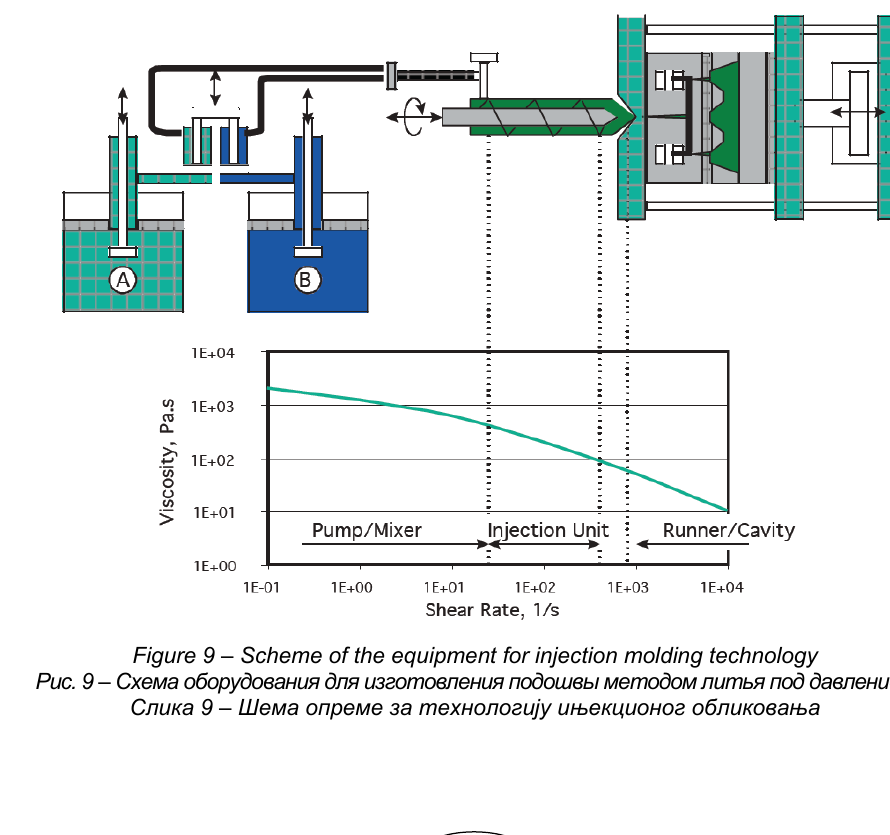
Figure 9 – Scheme of the equipment for injection molding technology Рис . 9 – Схема оборудования для изготовления подошвы методом литья под давлением Слика 9 – Шема опреме за технологију ињекционог